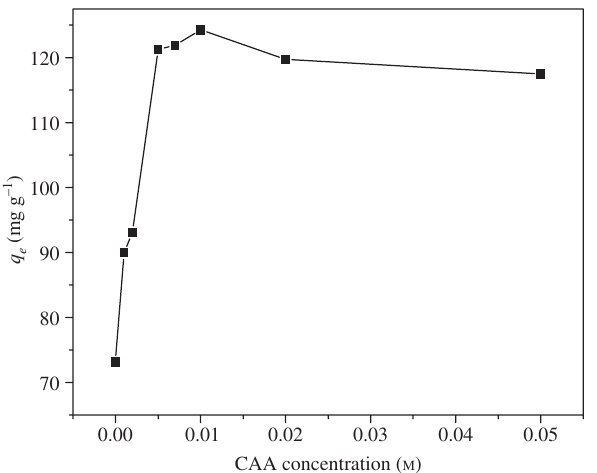
Figure 7: Effect of CAA concentration (when Fe with CAA) on the adsorption of MB by Fe pH 11 and 25 ° C.